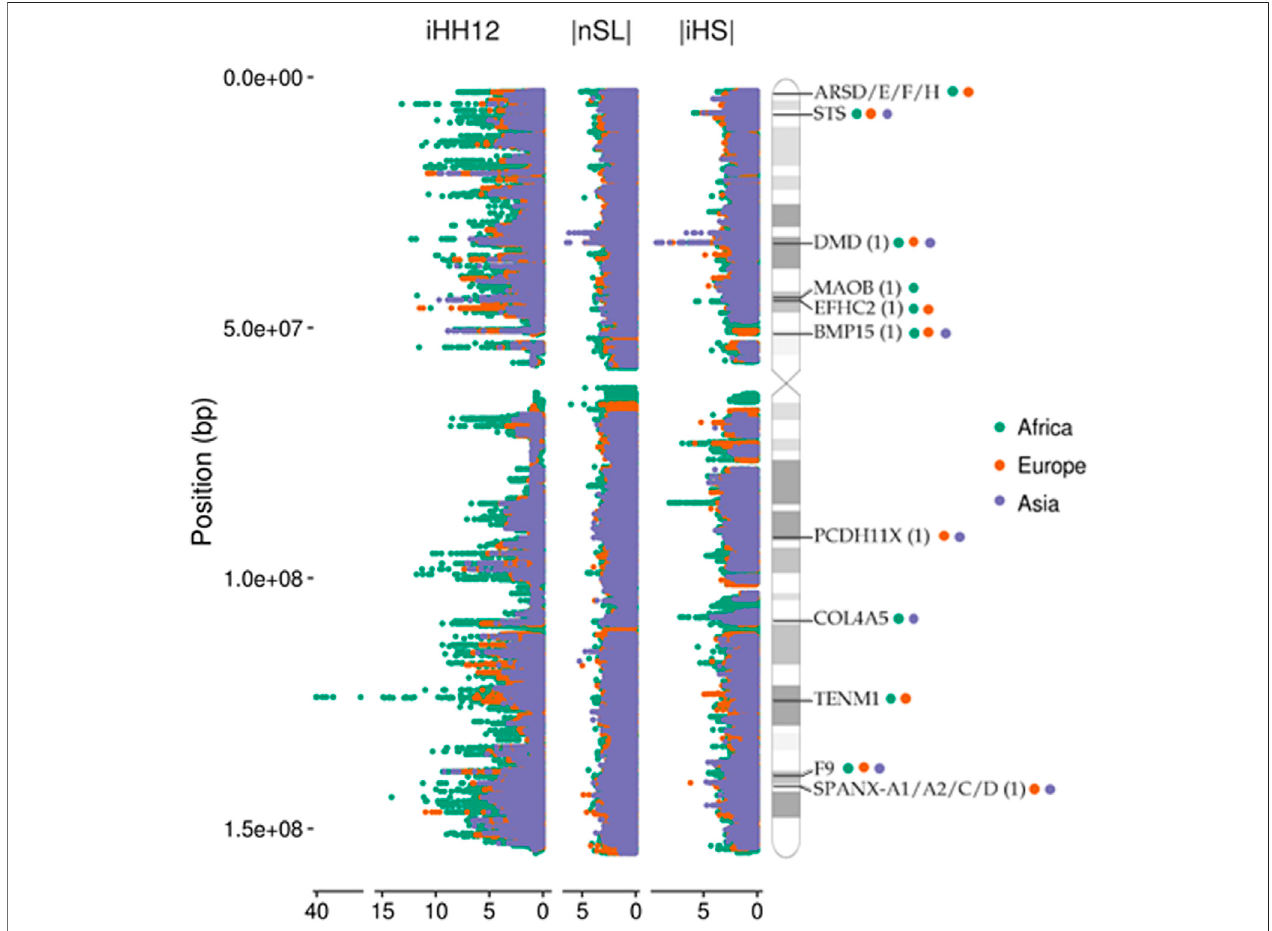
FIGURE1| ManhattanplotsoftheXchromosomeshowingthedistributionsofthethreeselectiontestsusedintheanalysis.Someexamplesofgenesfoundunder selection in continental groups (99th percentile; coloured circles) are shown in the ideogram. Candidates found in previous studies are indicated with (1).